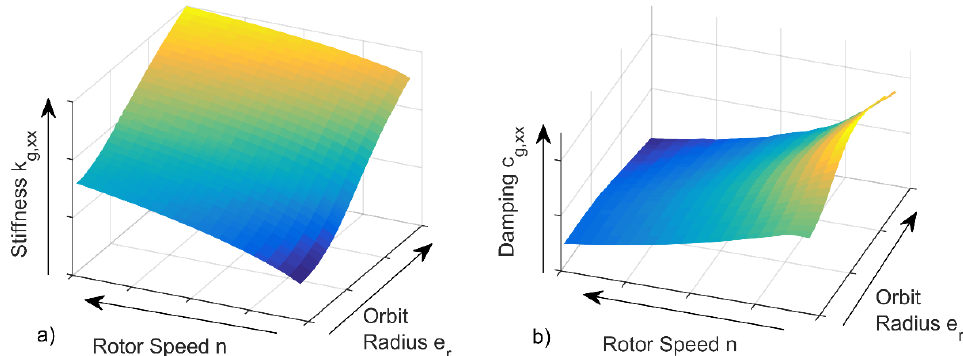
Figure 4. Global ( a ) stiffness and ( b ) damping coefficients.